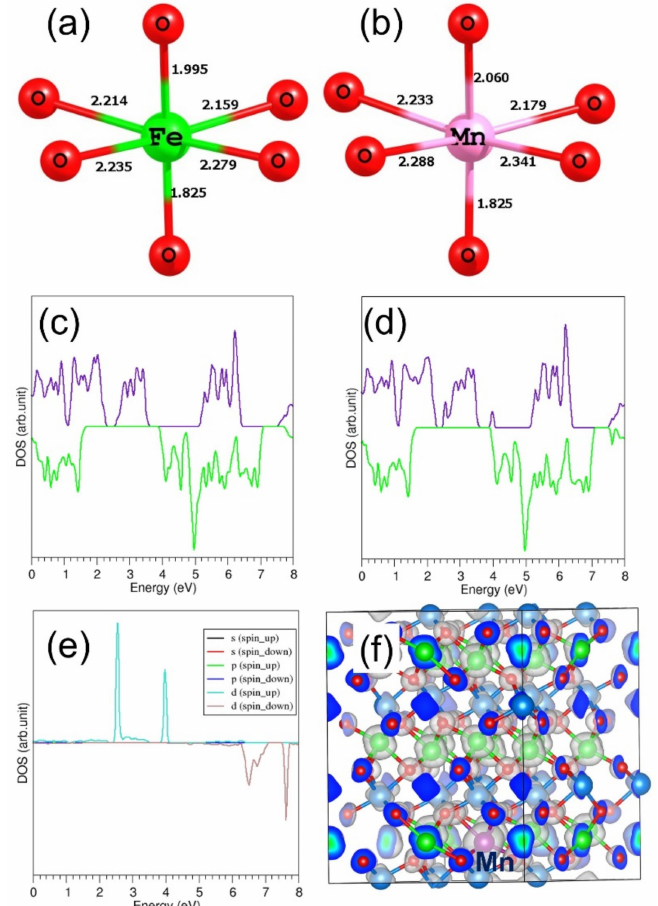
Figure 8. ( a ) FeO 6 octahedral unit showing bond lengths in the relaxed un-doped FeTiO 3 , ( b ) MnO 6 unit in the configuration of Mn 2 + doped at the Fe site, ( c ) total density of states (DOS) of FeTiO 3 , ( d ) total DOS of Mn-doped FeTiO 3 , ( e ) atomic DOS of Mn, and ( f ) constant charge density plot associated with the atomic DOS of